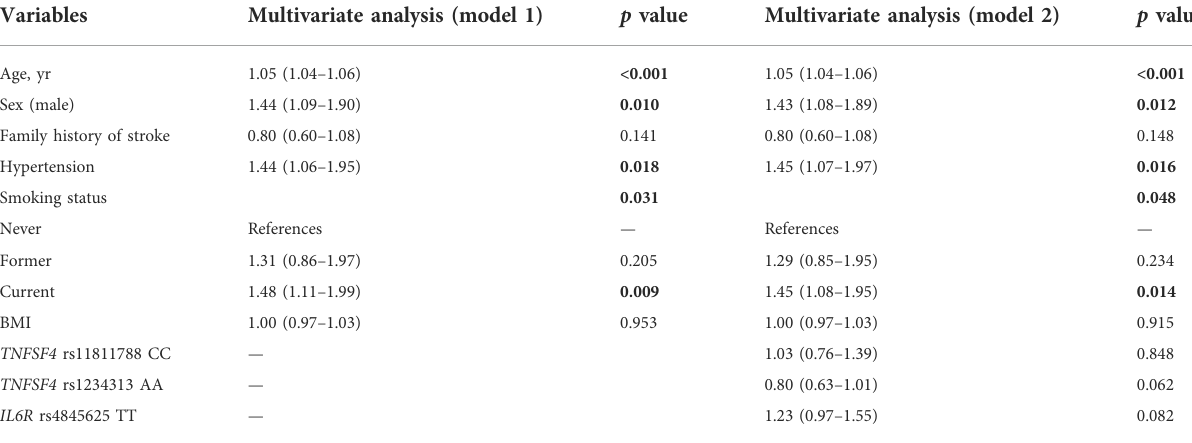
TABLE 3 Multivariable analyses for the risk factors associated with vulnerable carotid